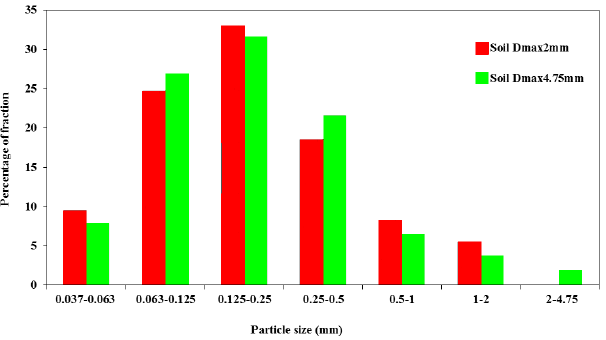
Figure 1. The fraction percentage obtained by the wet sieving pro- cedure.